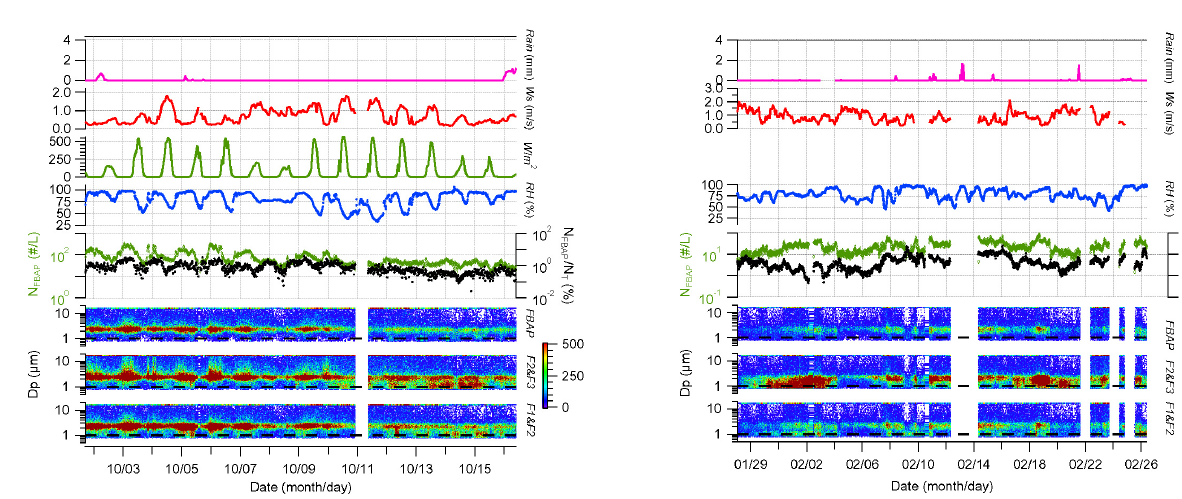
Fig. 14. WIBS-4 fluorescence data for a selected time period during autumn season in comparison with meteorological data measured at the same time. The data were plotted in the same way as in Fig. 12.